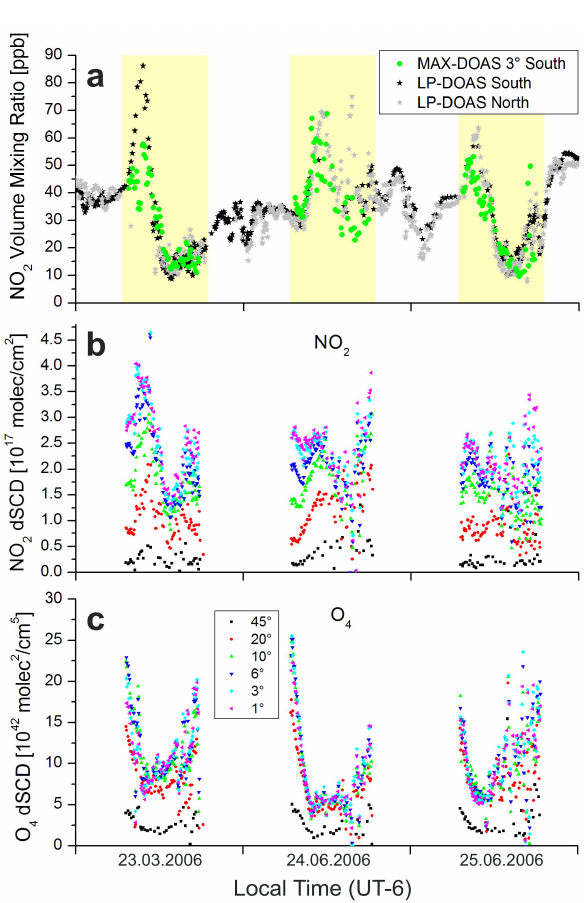
Fig. 7. (a) Comparison of MAX-DOAS pointing south and LP- DOAS pointing south and northwest for 3 arbitrary days. The light-yellow background indicates daylight (SZA < 90 ◦ ). The cor- responding dSCDS for (b) NO 2 and (c) O 4 are shown in the panels